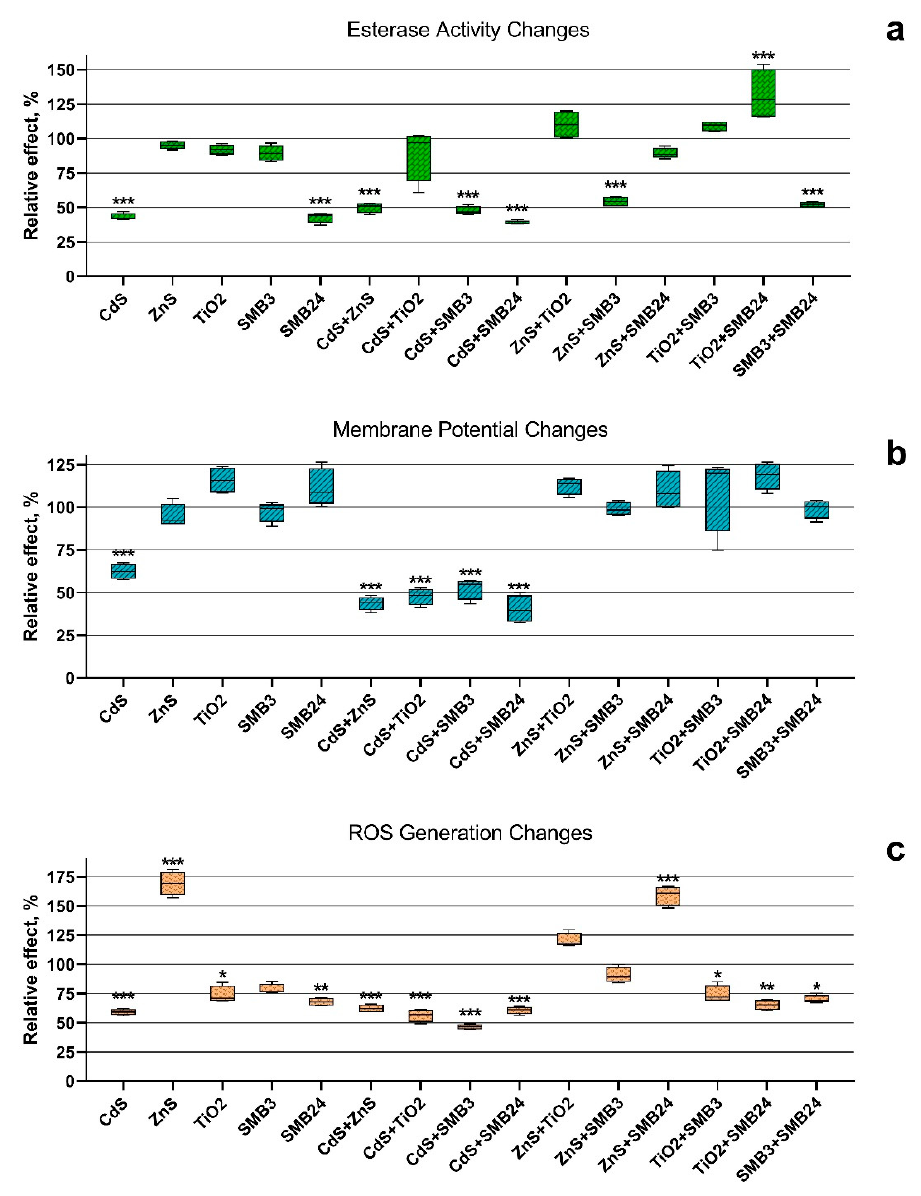
Figure 2. The biochemical changes in the cells of H. akashiwo exposed to the single and binary mixtures of the NPs. ( a ) Esterase activity changes. ( b ) Membrane potential changes. ( c ) ROS generation changes. *** p < 0.0001. ** p < 0.001. * p < 0.05.